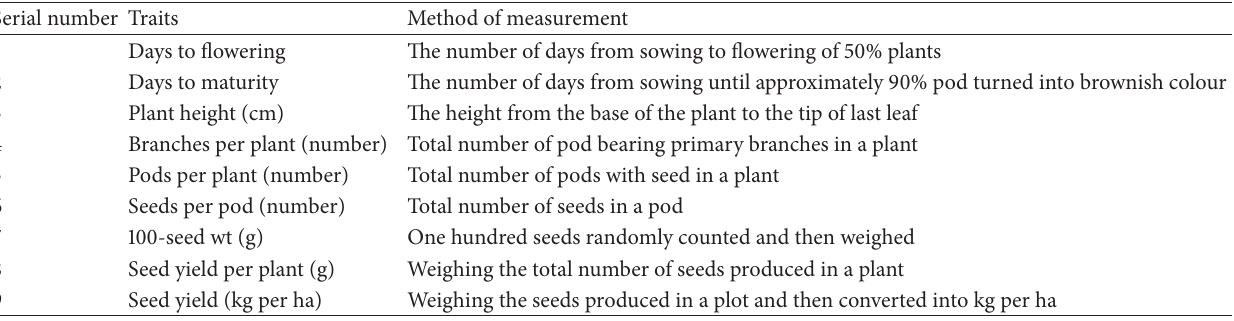
Table 2: List of different traits and their description of measurement.